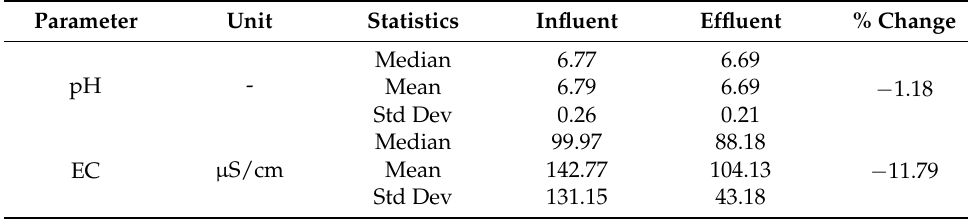
Table 3. Results of the pH and electrical